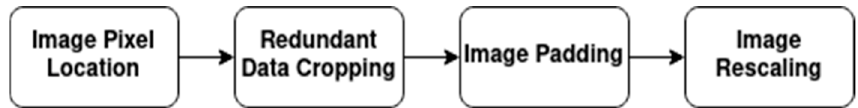
Figure 4. Data preprocessing algorithm flowchart.